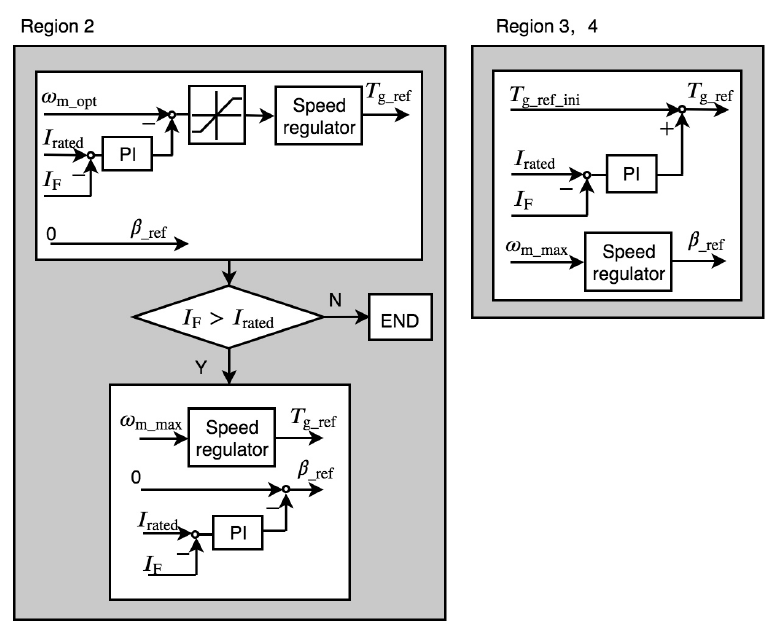
Figure 7. Flowchart of the ITSC FRT strategy, where I F is the current of the faulty phase, I rated is the rated current, T g_ref_ini is the generator torque reference the initial torque controller, ω m_max is the maximum rotor speed, β ref is the pitch angle reference, and ω m_opt is the optimal rotor speed according to